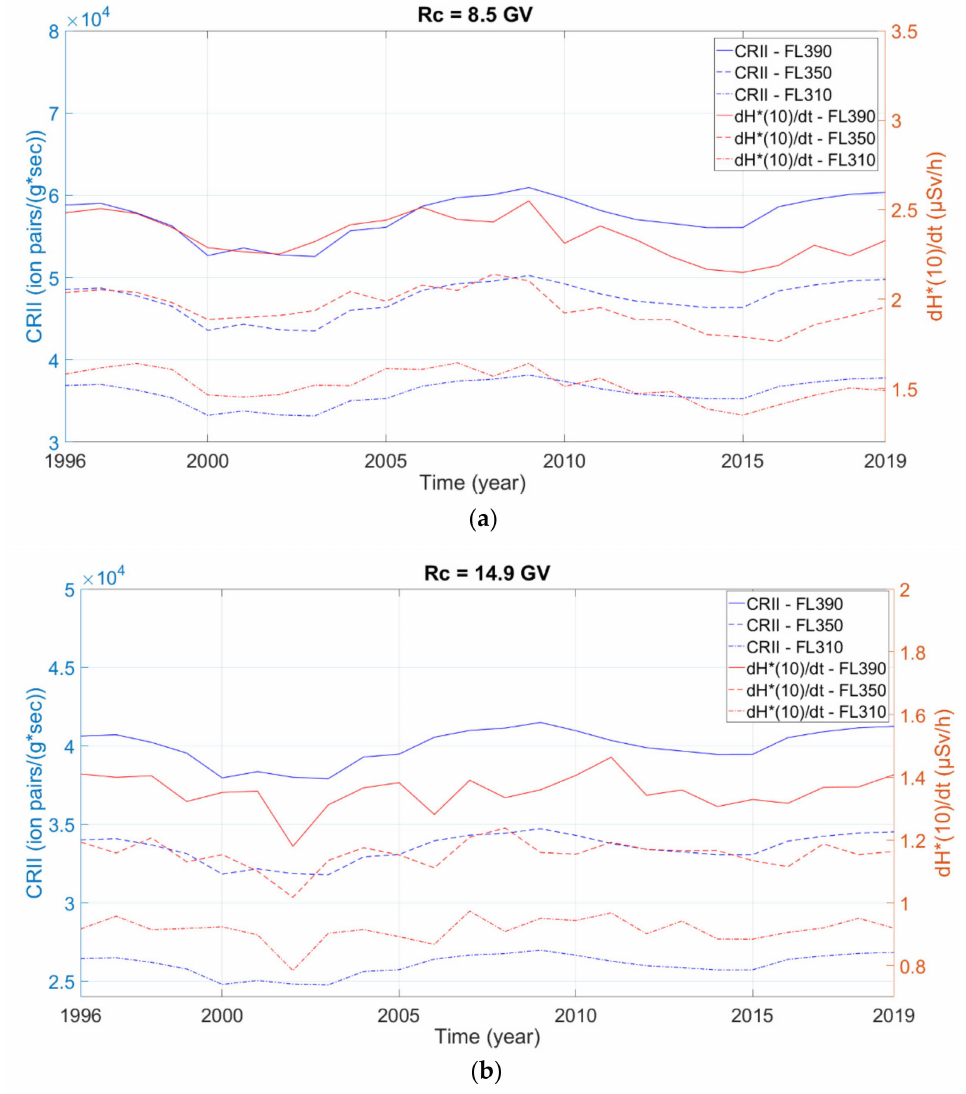
Figure 4. Yearly distribution of CRII rate (left axis, blue lines) and ambient dose equivalent rate (right axis, red lines) at three different flight levels (FL310, FL350, FL390), for the time period 1996–2019: ( a ) at a region with cut-off rigidity 8.5 GV; ( b ) an equatorial region with cut-off rigidity 14.9